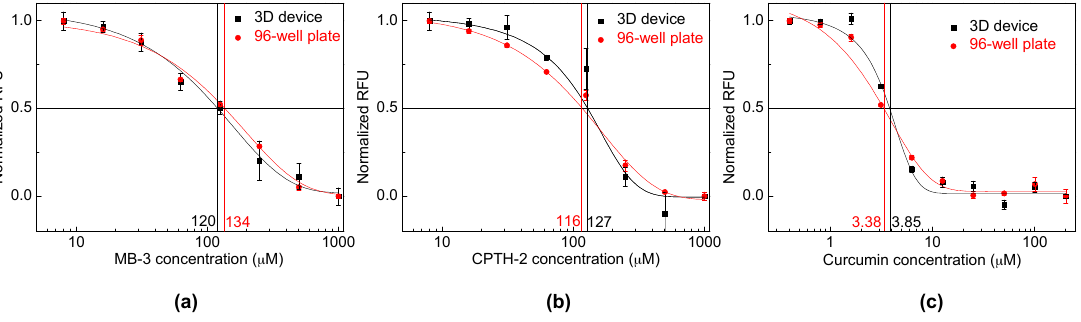
Figure 6. Drug response curves of the Pf GCN5 enzyme to ( a ) MB-3; ( b ) CPTH-2 and ( c ) curcumin on the 3D microfluidic device ( black ) and 96-well microtiter plate ( red ). Pf GCN5 was tested under serial concentrations of drugs. The plots show the normalized relative fluorescence unit as a function of drug concentration, where IC 50 is the drug concentration at which normalized relative fluorescence units (RFU) is 0.5, indicating 50% inhibition. The extracted IC 50 are indicated on the plot. Error bars correspond to three replicates.